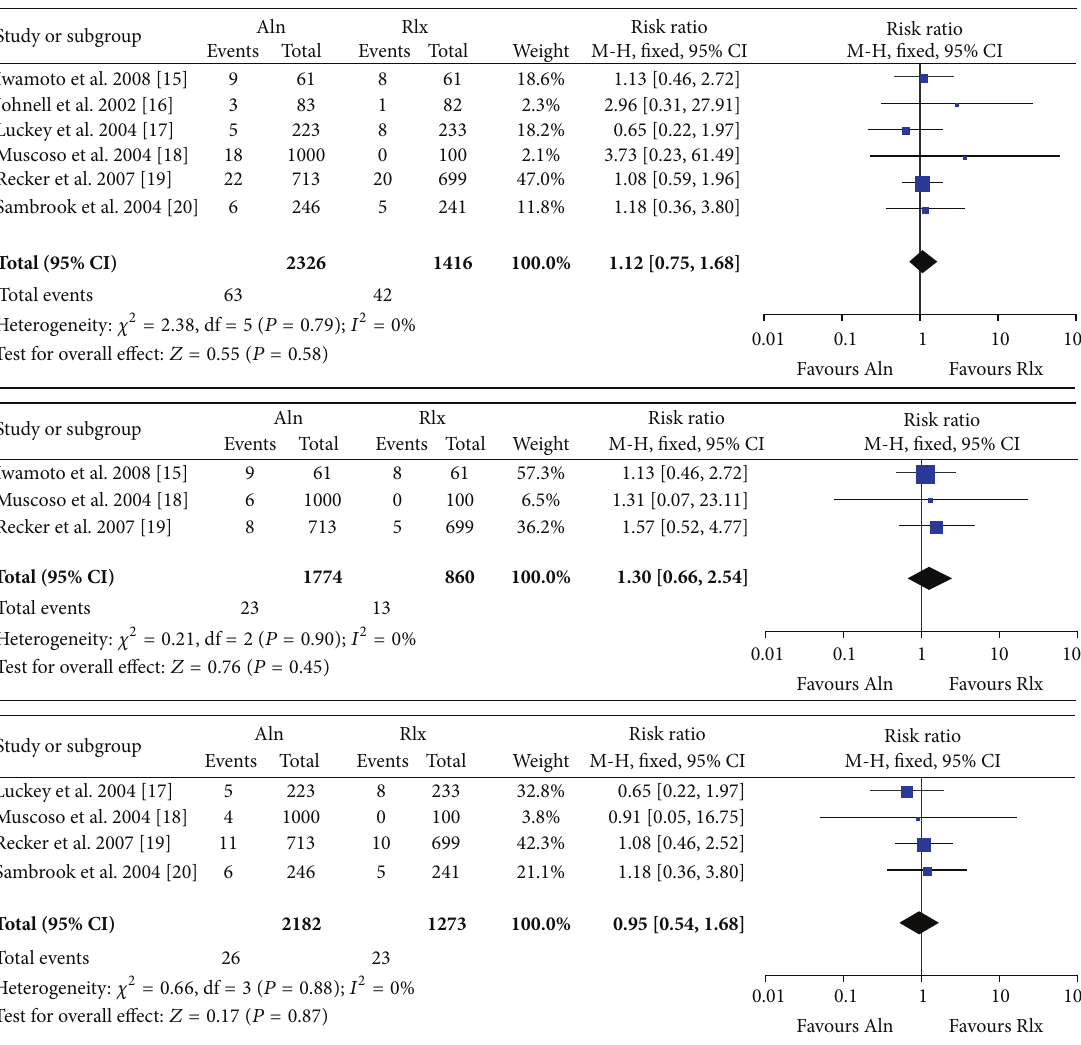
Test for overall effect: Z = 0.17 ( P = 0.87